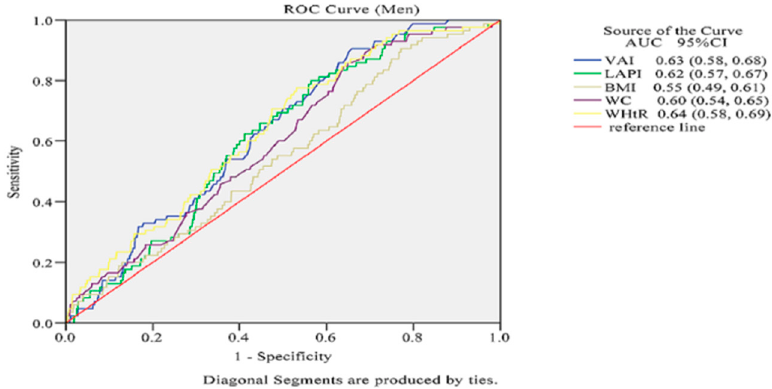
Figure 1. The discriminatory power of VAI, LAPI, BMI, WC and WHtR between subjects with or without CKD. Area under the receiver operating characteristic curve of VAI, LAPI, BMI, WC and WHtR to identify subjects with CKD according to sex.